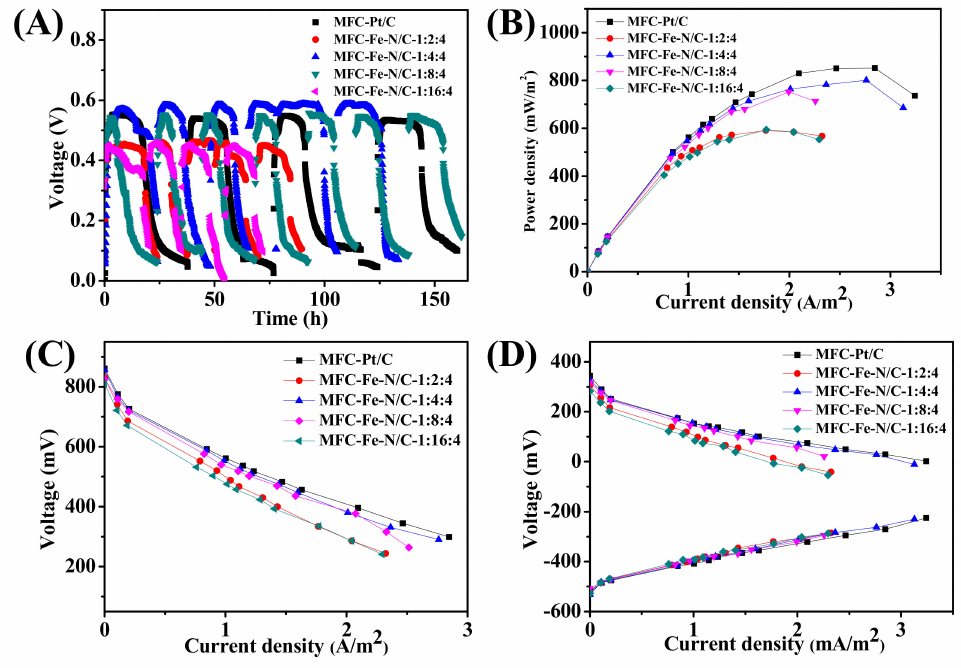
Figure 5. Electricity production performance of the MFCs using the catalysts with different N-doping contents. ( A ) The voltage output variation trend of the MFCs; ( B , C ) The power density and polarization curves of the MFCs, respectively; ( D ) The anode and cathode polarization